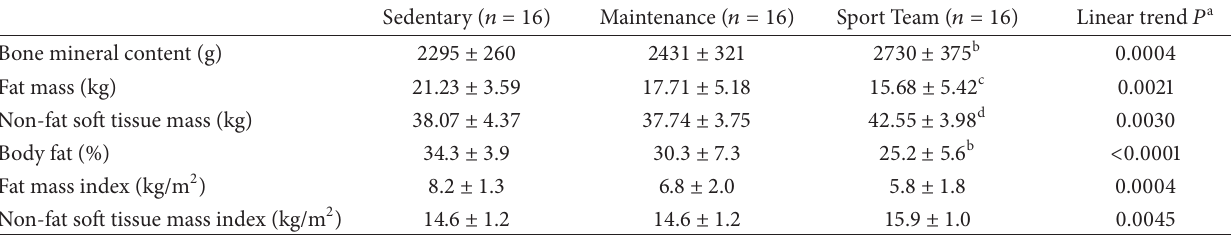
Table 2: Body composition